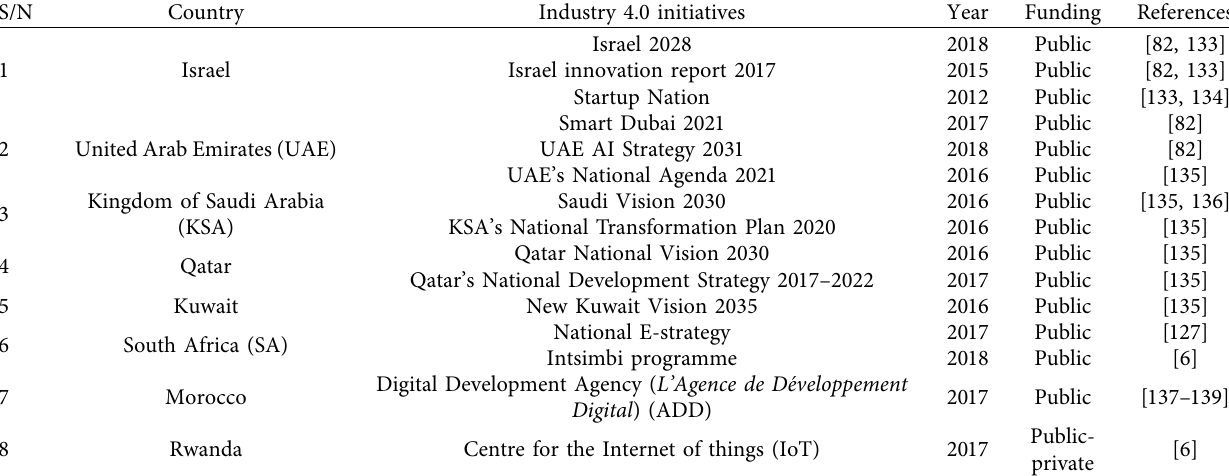
Table 5: Industry 4.0 initiatives launched in Middle East and